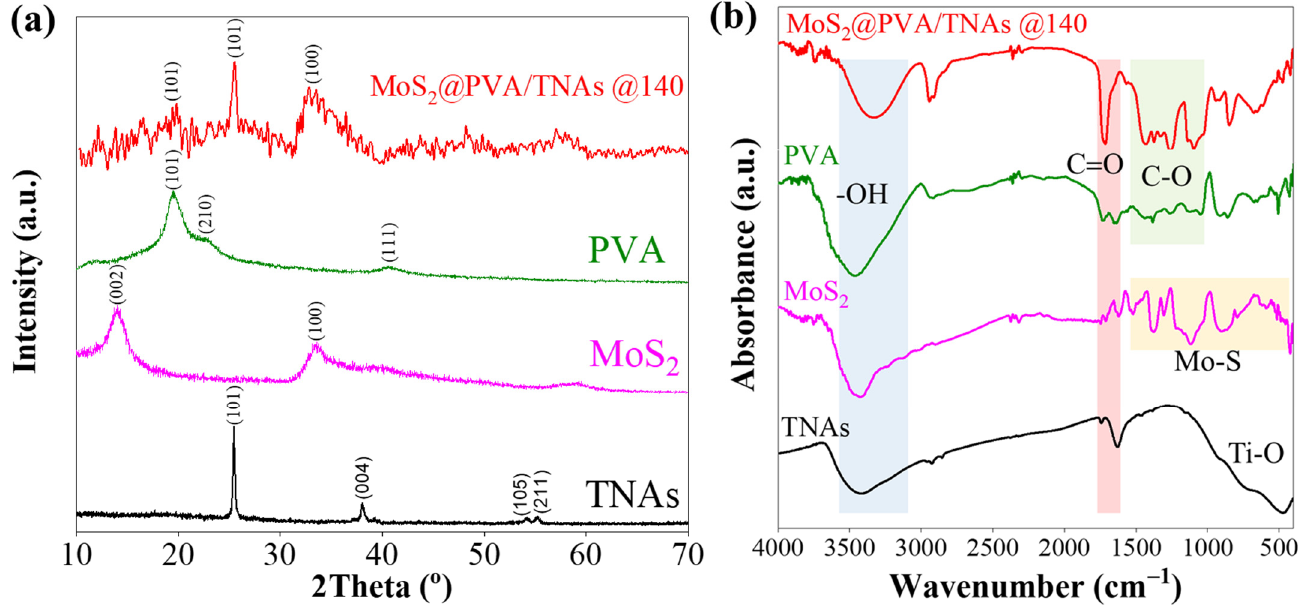
Figure 3. XRD patterns ( a ) and FTIR spectra ( b ) of TNAs, MoS 2 , PVA, and MoS 2 @PVA/TNAs@140.